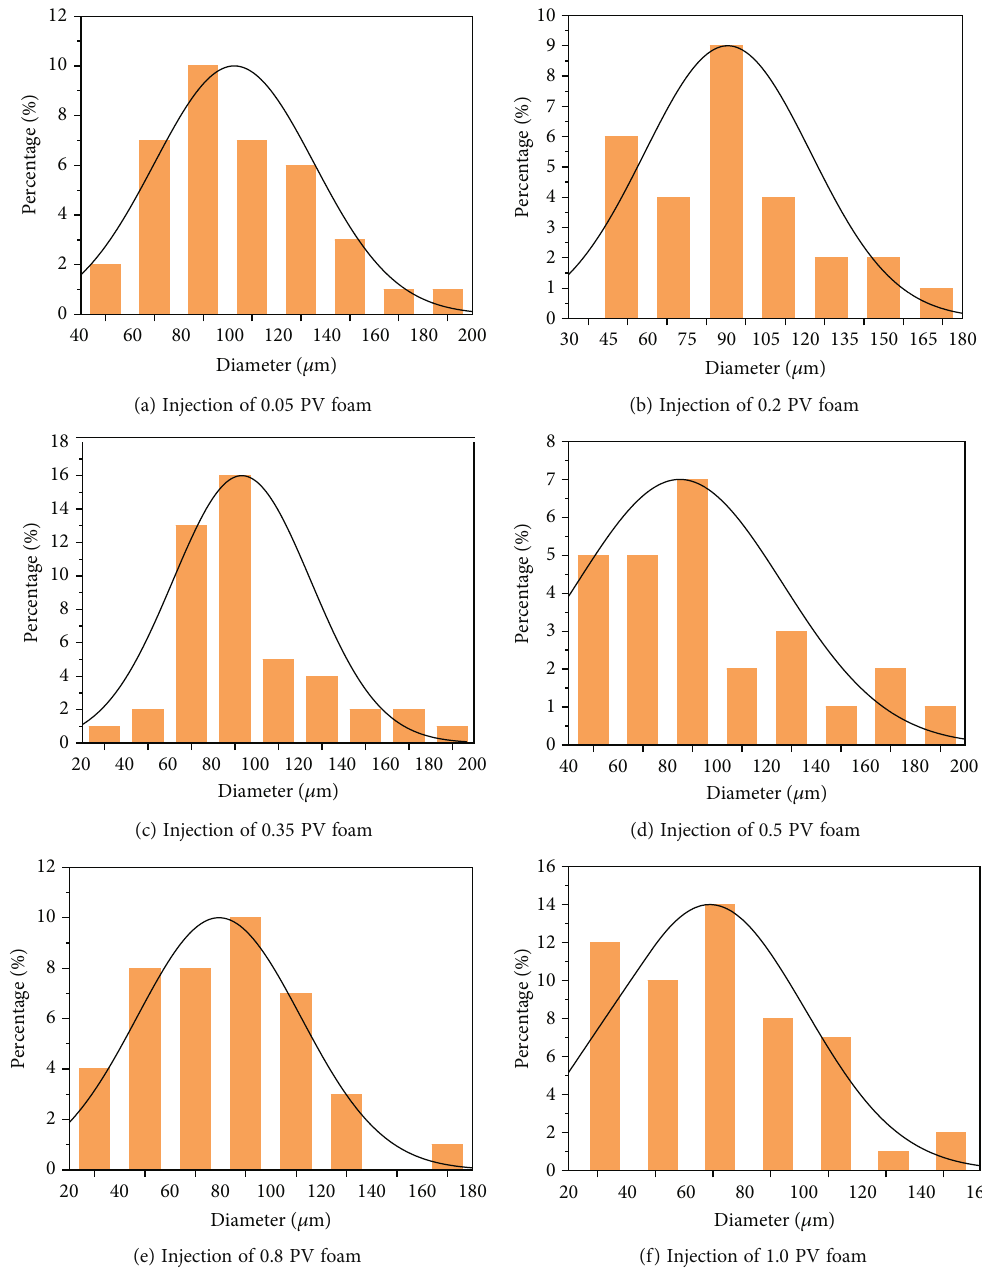
Figure 8: Bubble particle size distribution at di ff erent injection